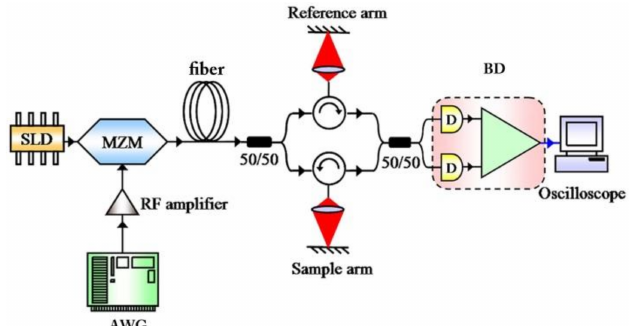
Figure 1. Optical design of the OC 2 T. SLD: super luminescent diode, MZM: Mach–Zehnder modula- tor, AWG: arbitrary waveform generator, RF: radio frequency, BD: balanced